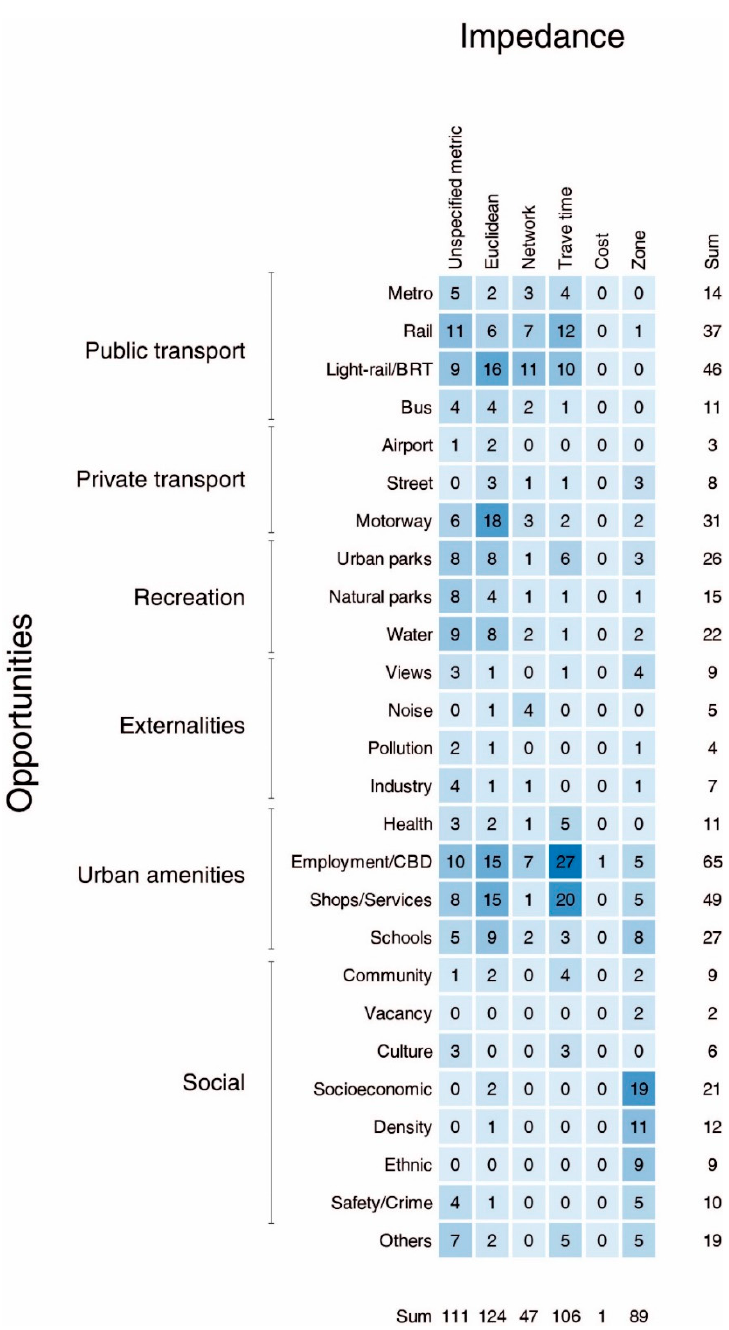
Figure 4. The frequency of the use of the specific combination of opportunities and impedance in the reviewed sample of papers. The numbers in the figure represent the amount of times the combination opportunity-type is used; the darker blue, the more frequent this combination is used; the sum shows the total amount of times the opportunity or impedance is used, irrespective of the other aspect.